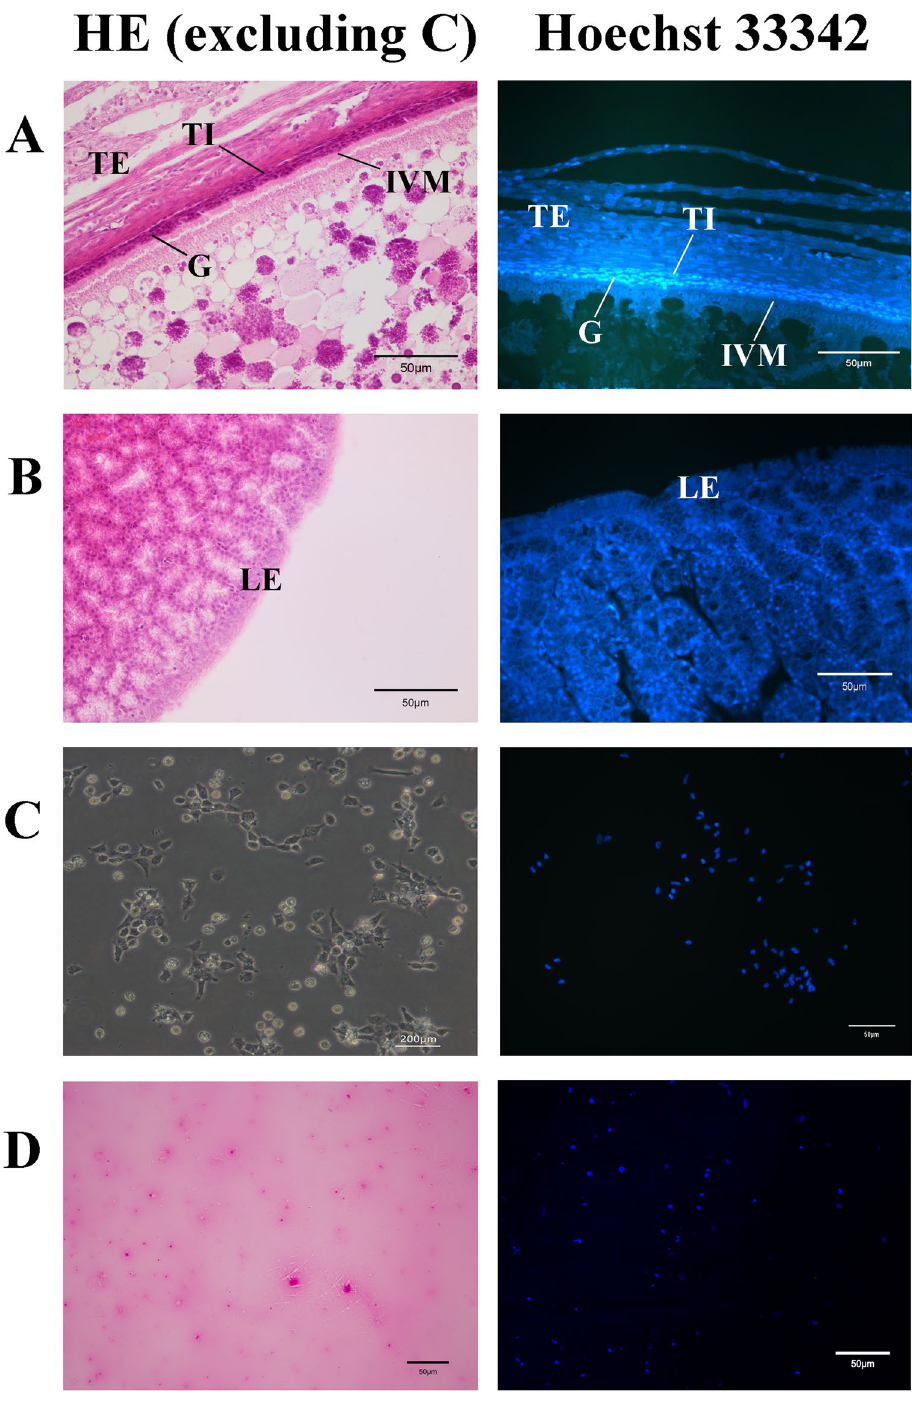
Figure 5. Histology observation of the follicle, infundibulum, granulosa cells and VM using HE and Fluorescent Hoechst 33342 staining. ( A ) The cross-sections of the enveloping layers of SYF ( Φ 6–8 mm, × 400). TE: theca externa; TI: theca interna; G: granulosa; IVM: inner vitelline membrane. ( B ) The cross-sections of the Infundibulum ( × 400). LE: luminal epithelium (numerous ciliated cells and very few secretory cells). ( C ) The granulosa cells from SYF after culture for 48 h ( × 200). The granulosa cells on the left side were directly examined without staining. ( D ) The maternal cell on the VM of 1d unfertilized egg ( ×